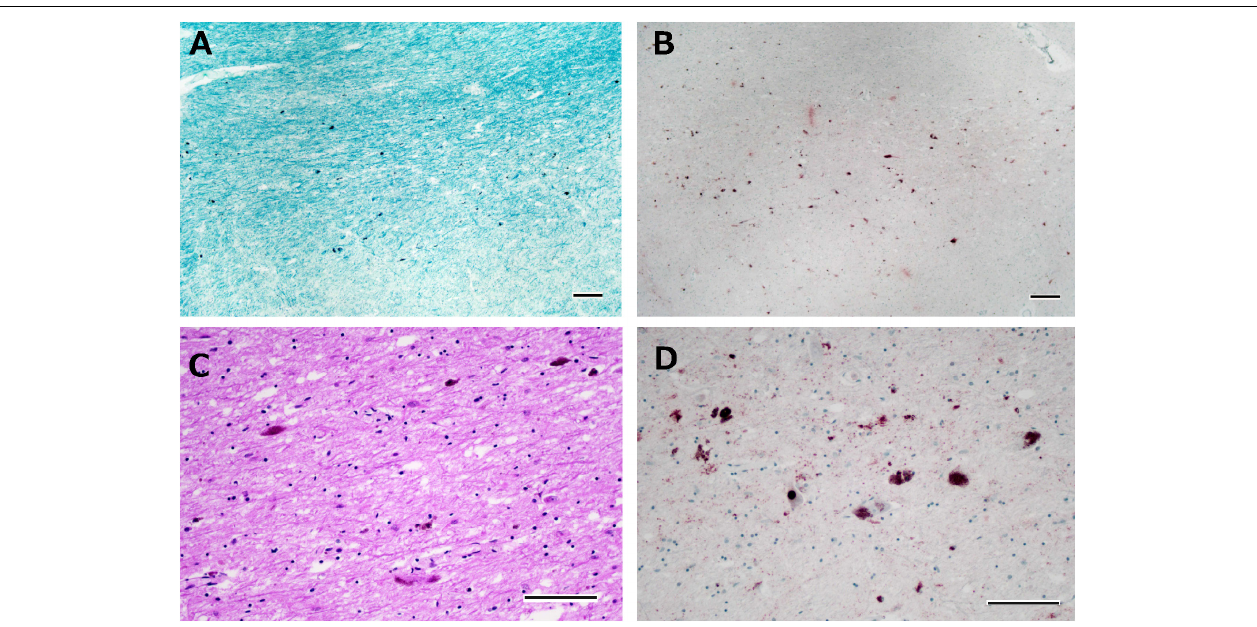
FIGURE 9 | Histological observations of the substantia nigra from Case 6. Neuronal loss is observed in the intermediate portion of the substantia nigra (A) , where phosphorylated TDP-43-positive structures are depicted (B) . Astrogliosis is moderately severe (C) , and phosphorylated TDP-43-positive neuronal inclusions and dot-like deposits are identified (D) . Klüver-Barrera staining (A) , immunostaining for phosphorylated TDP-43 (B,D) , and hematoxylin-eosin staining (C) . Scale bars: 200 µ m (A,B) and 100 µ m (C,D)